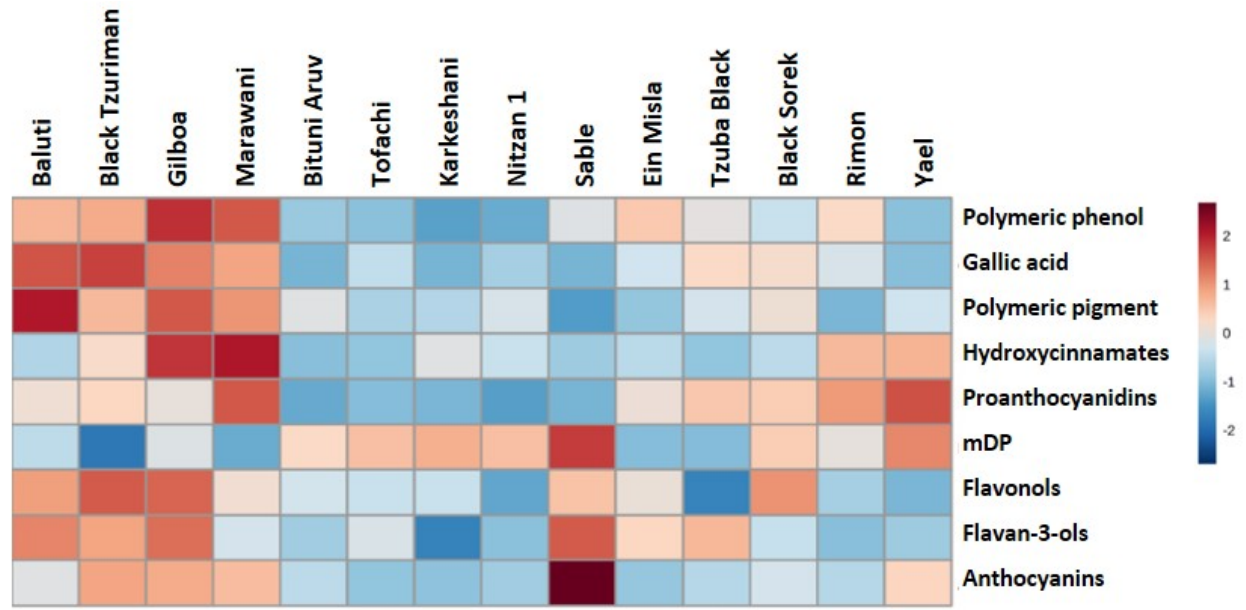
Figure 5. Mean monomeric and proanthocyanidin compositions of indigenous black grape varieties ( n = 3 replicates per variety). mDP is the mean degree of polymerization, calculated from the sum of all subunits (flavan-3-ol monomer and phloroglucinol adduct, in nmoles, divided by the sum of all flavan-3-ol monomers, in nmoles). All other analytes are reported as mg/g berries in (+) catechin equivalents; for this visualization, mean concentrations were normalized across the observed concentration range, as shown in the figure key. For numerical data, see Supplementary Materials Table S1.